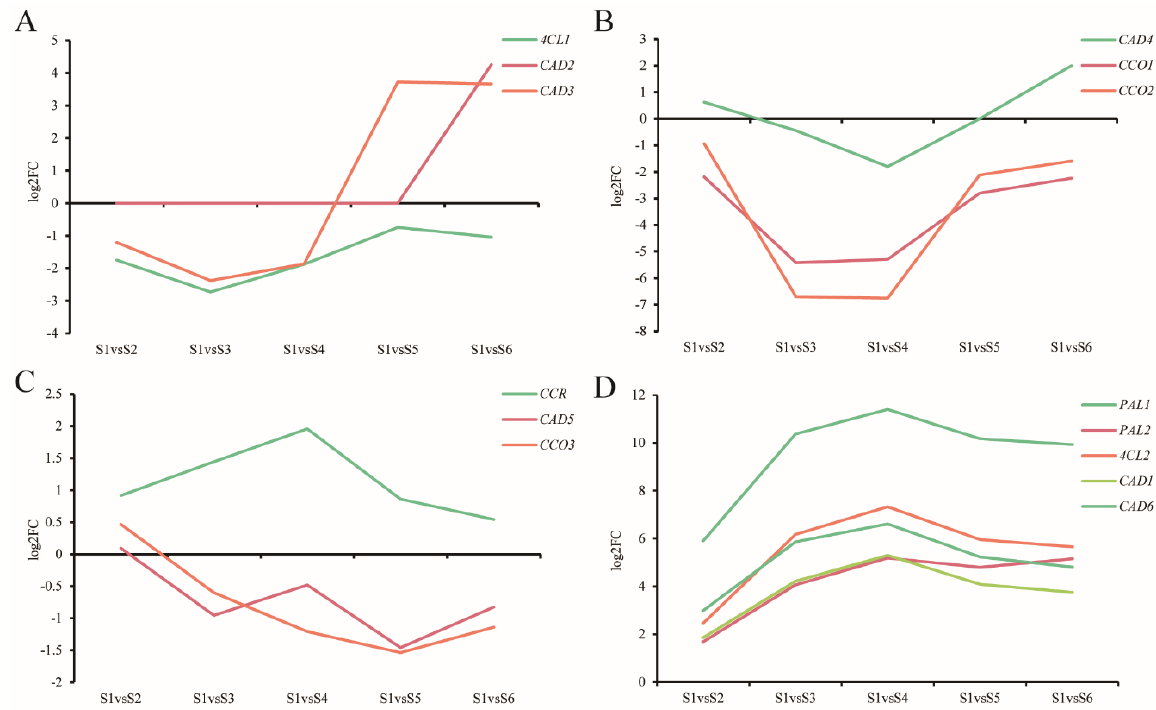
Figure 10. The log 2 of the fold change variations of lignin-related genes among five time points. ( A ) includes 4CL1 , CAD2 and CAD 3 ; ( B ) includes CAD4 , CCO1 and CCO2 ; ( C ) includes CCR , CAD5 and CCO3 and ( D ) includes PAL1 , PAL2 , 4CL2 , CAD1 and CAD6 . We clustered together genes with similar trends.